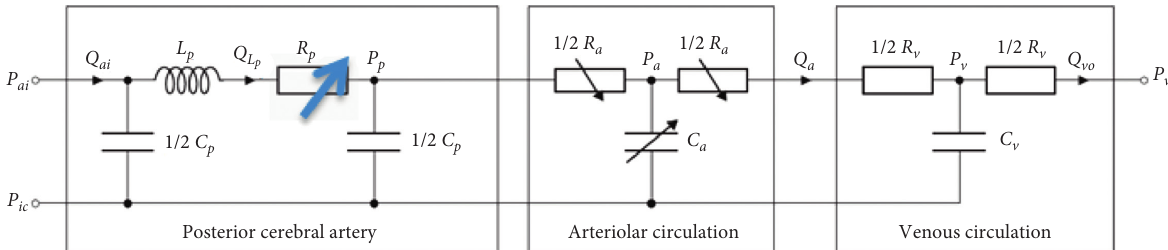
P P ai , ic , and v 0 : arterial